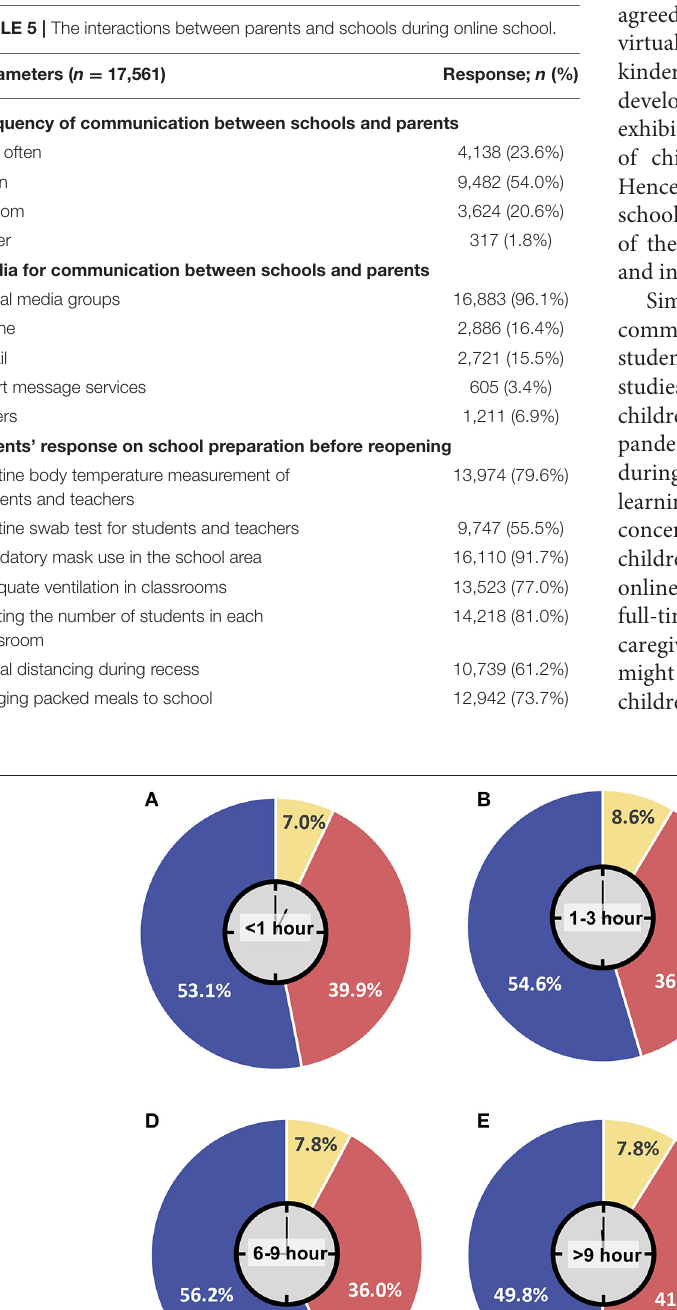
Frontiers in Public Health |